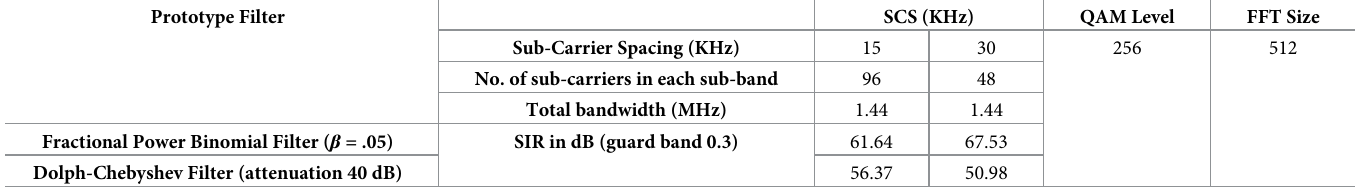
Table 2. Simulation parameters for different sub-carrier spacing of UFMC for SIR estimation (Parameters for UFMC based NR with two different proto-type filters). Prototype Filter